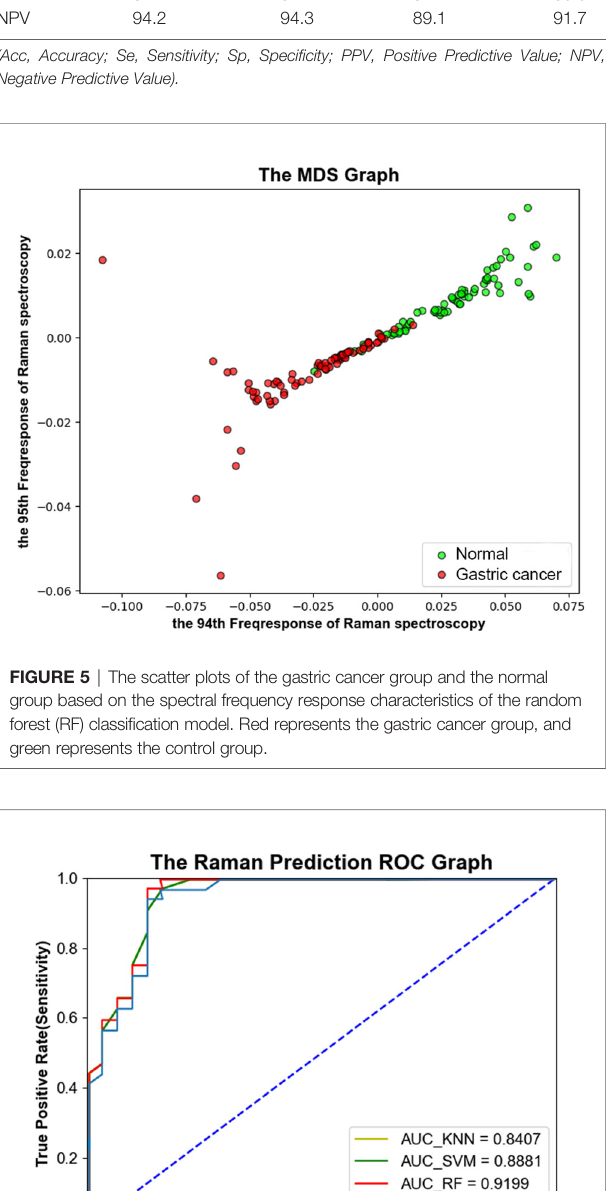
TABLE 4 | Test performance evaluation of one-dimensional convolutional neural network (1D-CNN) model under three division ratios. Division